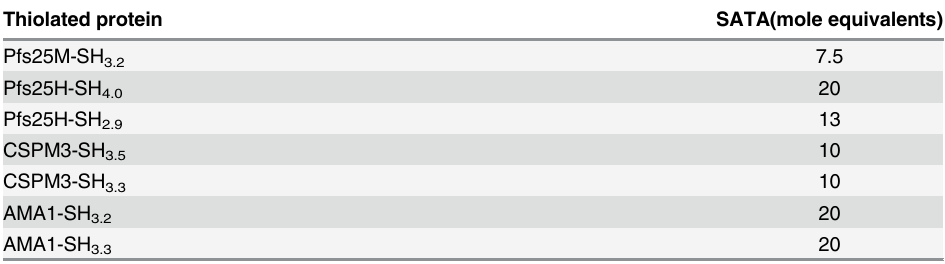
Table 1. Thiolation reaction parameters a